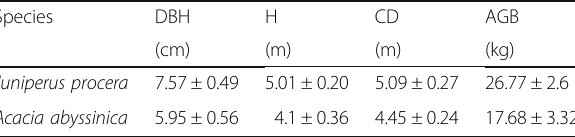
Table 1 Average (± standard error) woody plant dendrometric variables and total dry aboveground biomass (AGB) for the sample woody plants ( n = 39) in the Gergera watershed, Ethiopia Species DBH H Juniperus procera